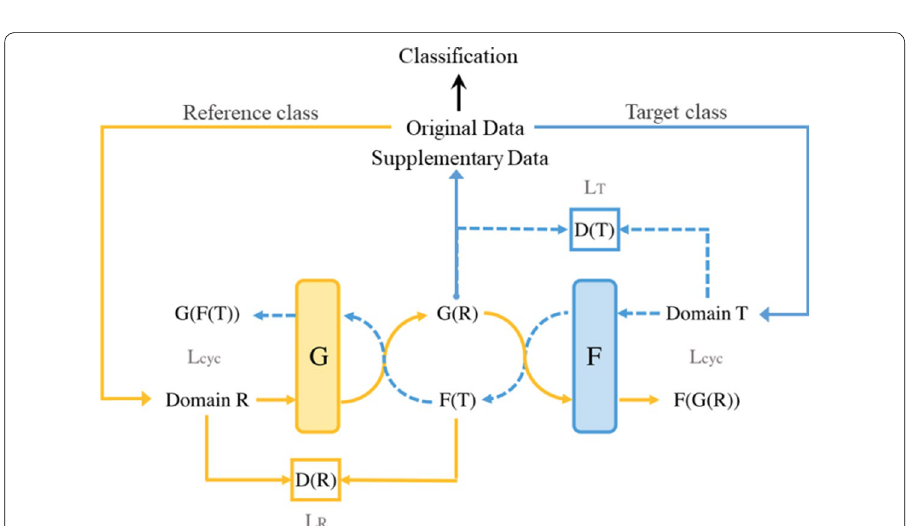
Fig. 20 Architecture overview: G and F consist of two separate GANs composing the CycleGAN. Two images are taken from the reference and target class and used to generate new data in the target